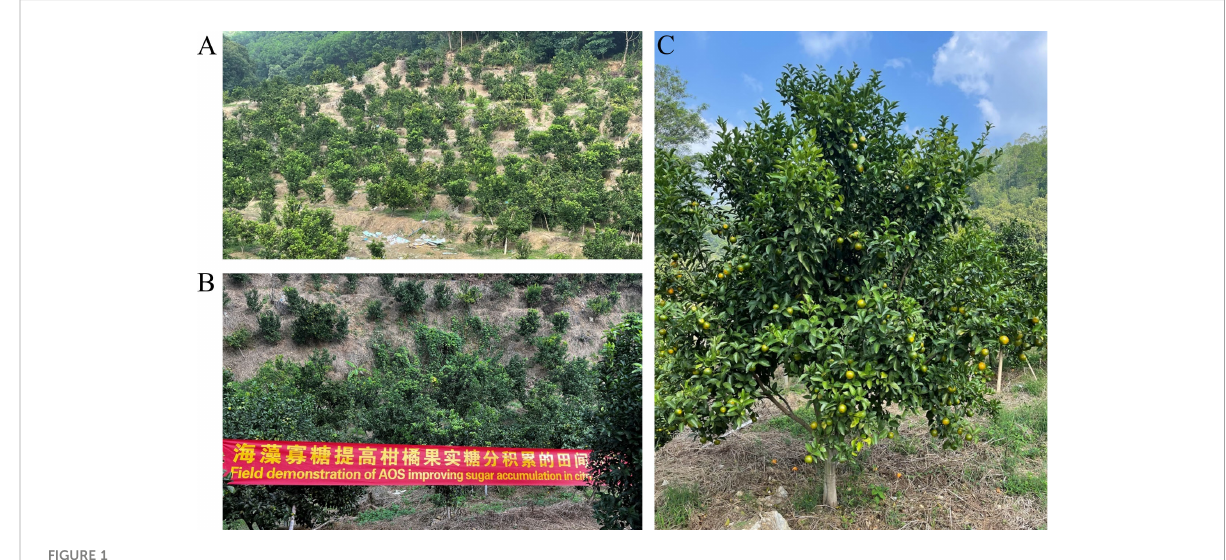
FIGURE 1 Citrus test site scenario map (A, B) , Citrus fruit tree diagram (C)